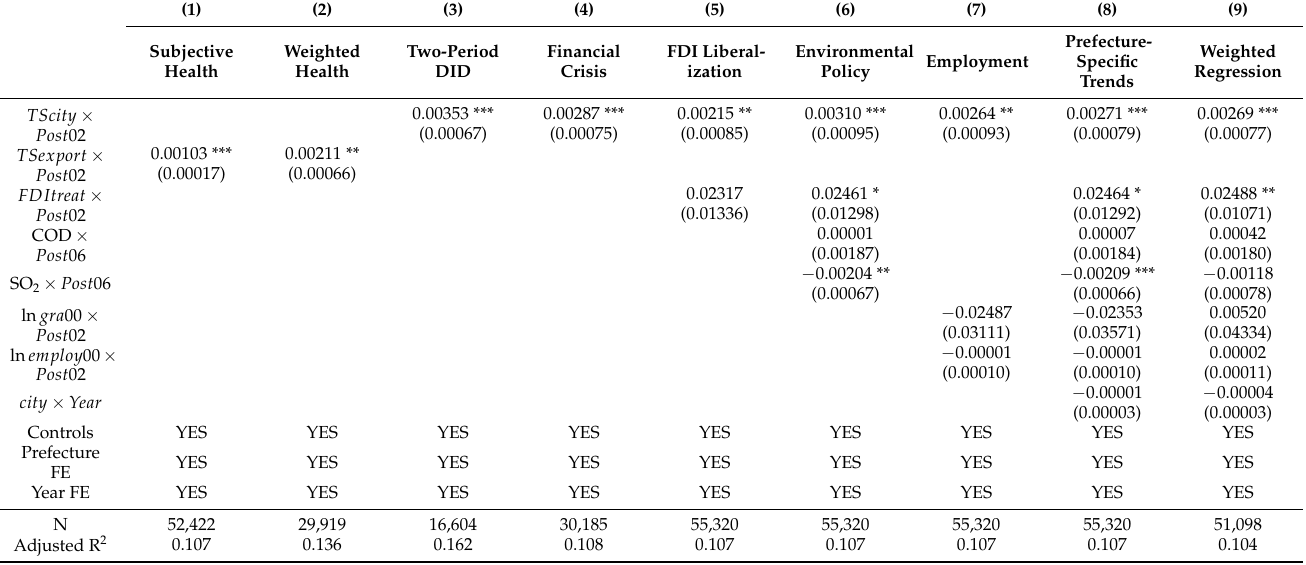
Table 4. Robustness